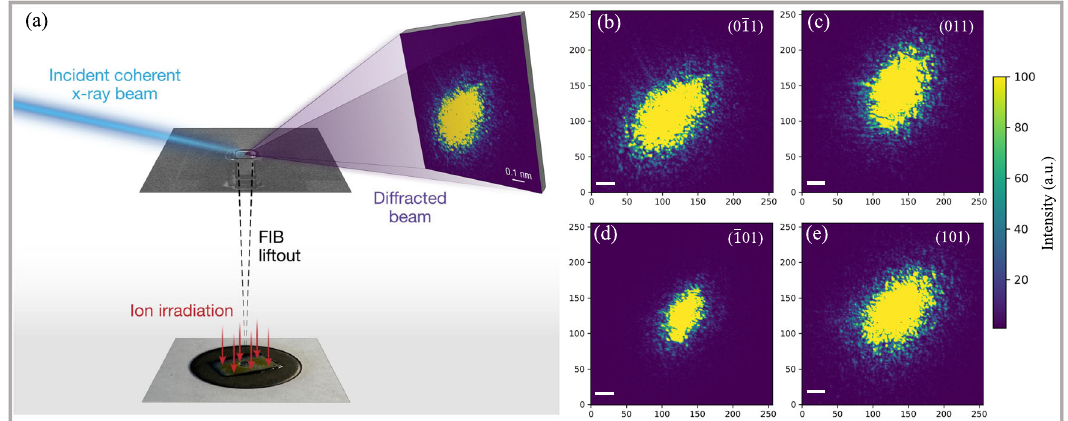
Fig. 2 Schematic of the BCDI experiment and 2D diffraction patterns. a Diagram of the experimental setup used the BCDI measurements in this work. Coherent X-rays from a synchrotron source are directed to the sample using a Kirkpatrick – Baez mirror (not shown) and are diffracted by the Fe ion irradiated chromium crystal. The constructive interference patterns of the diffracted X-rays are recorded while rocking the sample in theta in steps of about 0.001° about the Bragg condition for four non-coplanar Bragg ’ s peaks, effectively measuring the three- dimensional Bragg peak. When the Bragg peak is suf fi ciently over-sampled, it is possible to apply established phase retrieval algorithms to solve for the complex wave function of the scattered X-rays. b – e Central slices of the 3D coherent X-ray diffraction pattern for each re fl ection measured on the ion-implanted sample. The scale bar was calculated using the relationship 2 π p = λ d , where λ ¼ 0 : 138nm is the wavelength, p ¼ 55 μ m is the detector pixel size, and d ¼ 2 : 0m is the sample to detector distance. The scale bar shown corresponds to 0.1 nm − 1